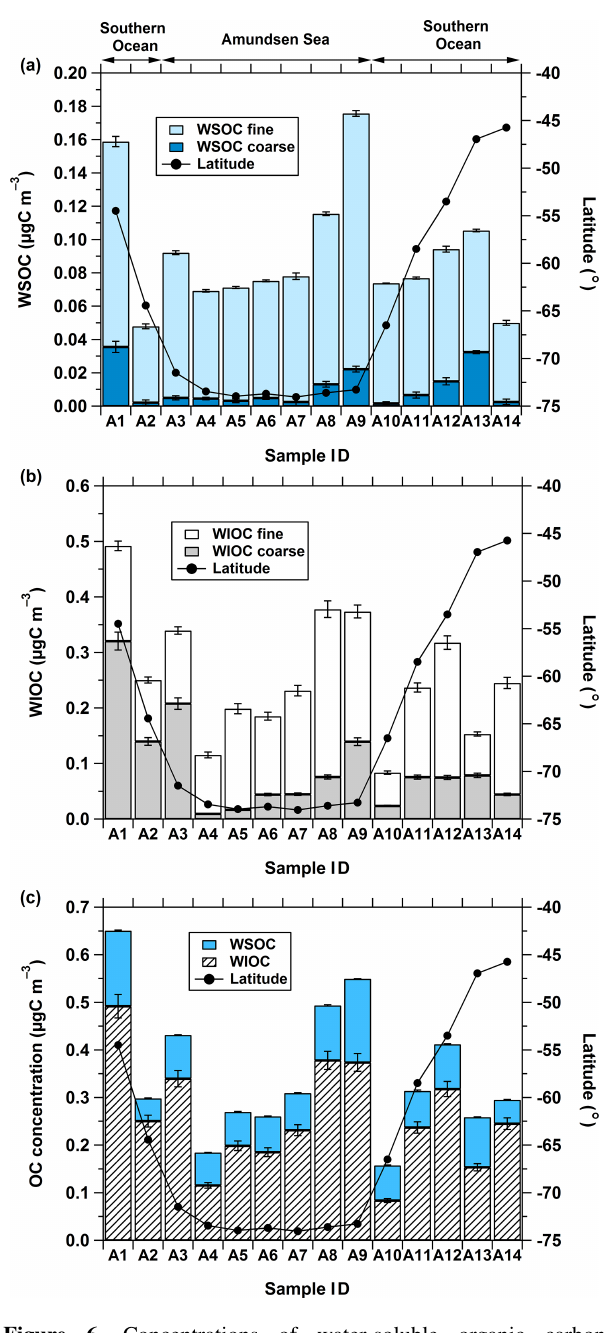
Figure 6. Concentrations of water-soluble organic carbon (WSOC) (a) , water-insoluble organic carbon (WIOC) (b) and or- ganic carbon (i.e., OC = WSOC + WIOC) (c) against sample ID in aerosols collected over the Southern Ocean (43–70 ◦ S) and the Amundsen Sea (70–75 ◦ S). Black solid lines with circles indicate the latitude of the halfway point between each aerosol sampling start point and endpoint. Double arrows in (a) show the sampling locations of aerosol